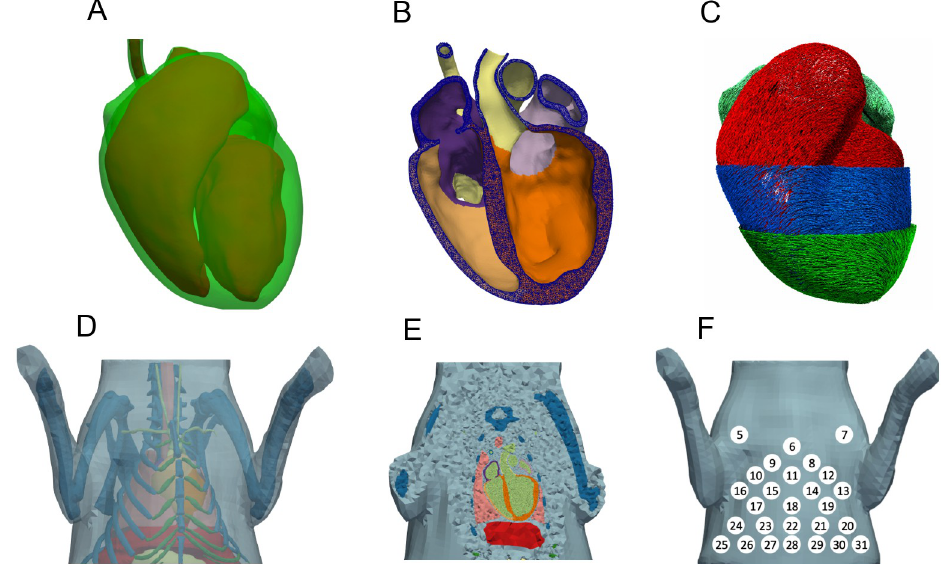
Fig 6. Heart and Torso surfaces and geometry. A: Surfaces of the endocardium (red, solid) and epicardium (green, transparent) of the heart. B: Open cut through meshed (tetrahedral) geometry of the heart. C: Representation of cardiomyocyte orientation of the heart, with the ventricles being visualized on endo-, mid-, and epicardial areas. D: Surface of the rabbit torso and all its organs (Light-blue: fat, Dark-blue: bones, Dark-green: cartilage; Salmon: lungs, Red: liver; Light-green: blood, Light-yellow: stomach). E: Open cut through the meshed geometry of the torso. F: Location of the ECG-Leads on the ventral side of the rabbit vest (5–31).